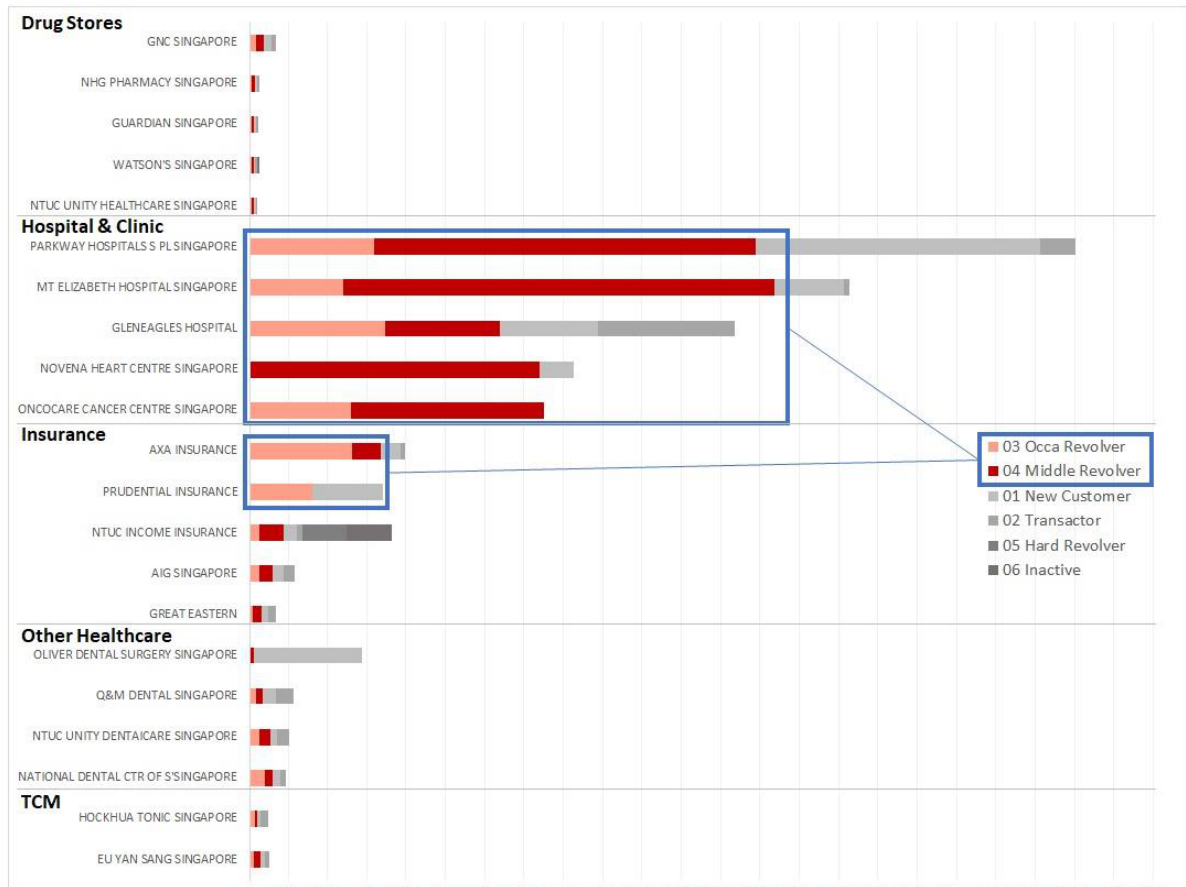
Figure 10. Average spending on healthcare-related merchants by revolving